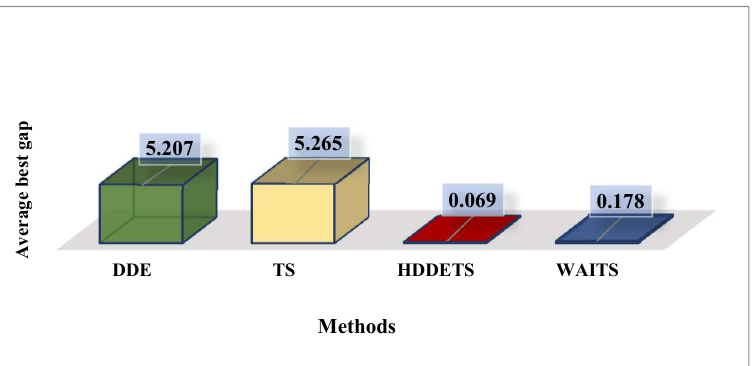
Fig. 2 . comparison among DDE, TS, HDDETS, and WAITS